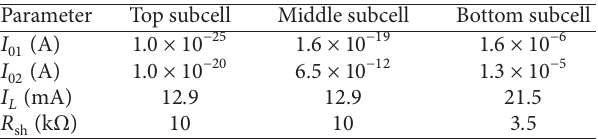
Table 1: Triple junction solar cell parameters as obtained by curve- fitting simulated subcell IV curves at 1